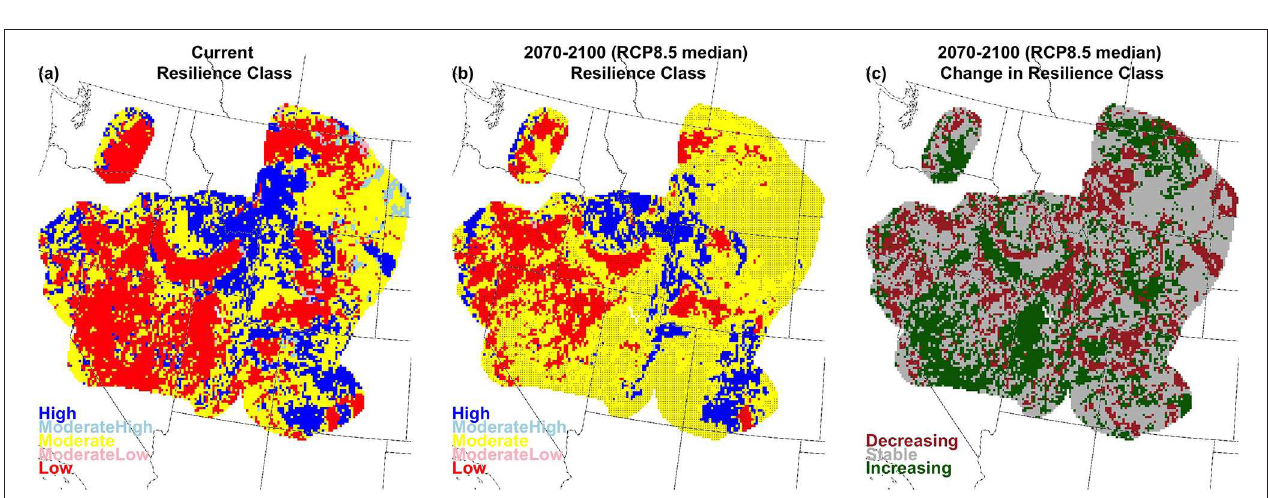
FIGURE 9 | Current (a) , future ( b ; 2070–2100; RCP8.5 median model), and change (c) for resilience in big sagebrush areas, characterized by greater sage-grouse management zones, which are outlined